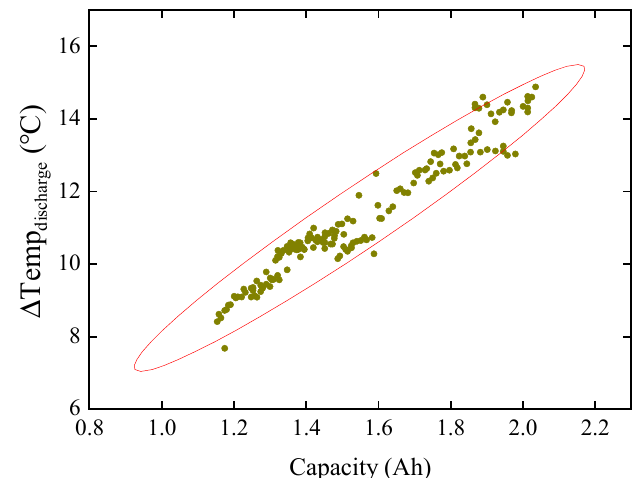
Figure 8. Scatter figure of ∆ Temp discharge .